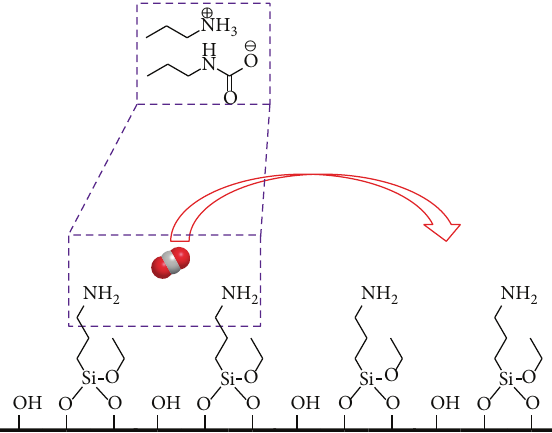
Figure 7: Mechanism of CO 2 adsorption on an amine-oxide surface and facilitated transport of a CO 2